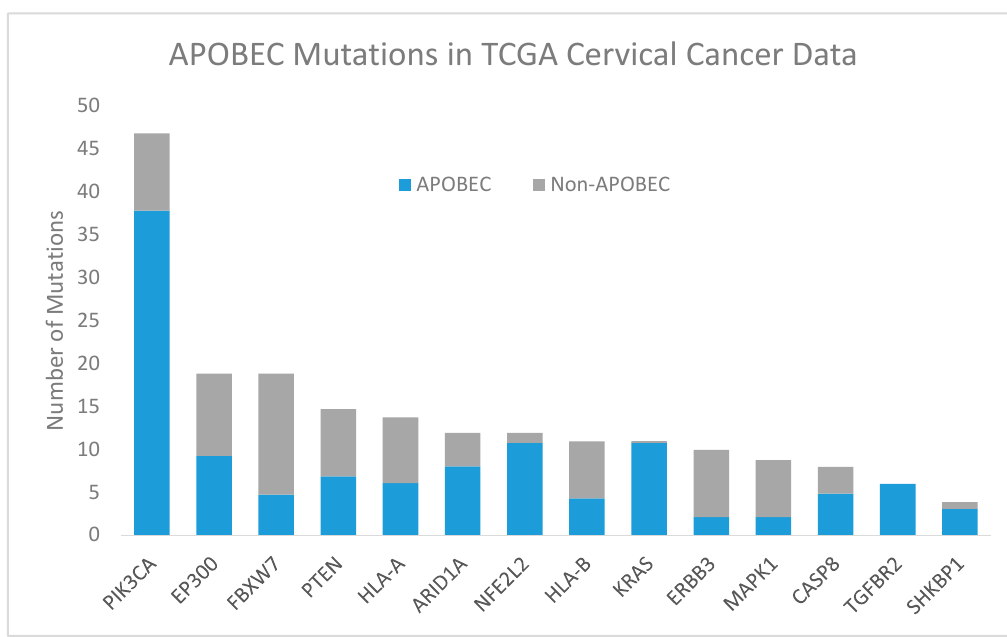
Figure 3. Apolipoprotein B mRNA editing catalytic polypeptide-like (APOBEC, blue) and non-APOBEC (gray) mutations in significantly mutated genes in TCGA cervical cancer data [18]. Abbreviations: PIK3CA, phosphatidylinositol-4,5-bisphosphate 3-kinase catalytic subunit alpha;